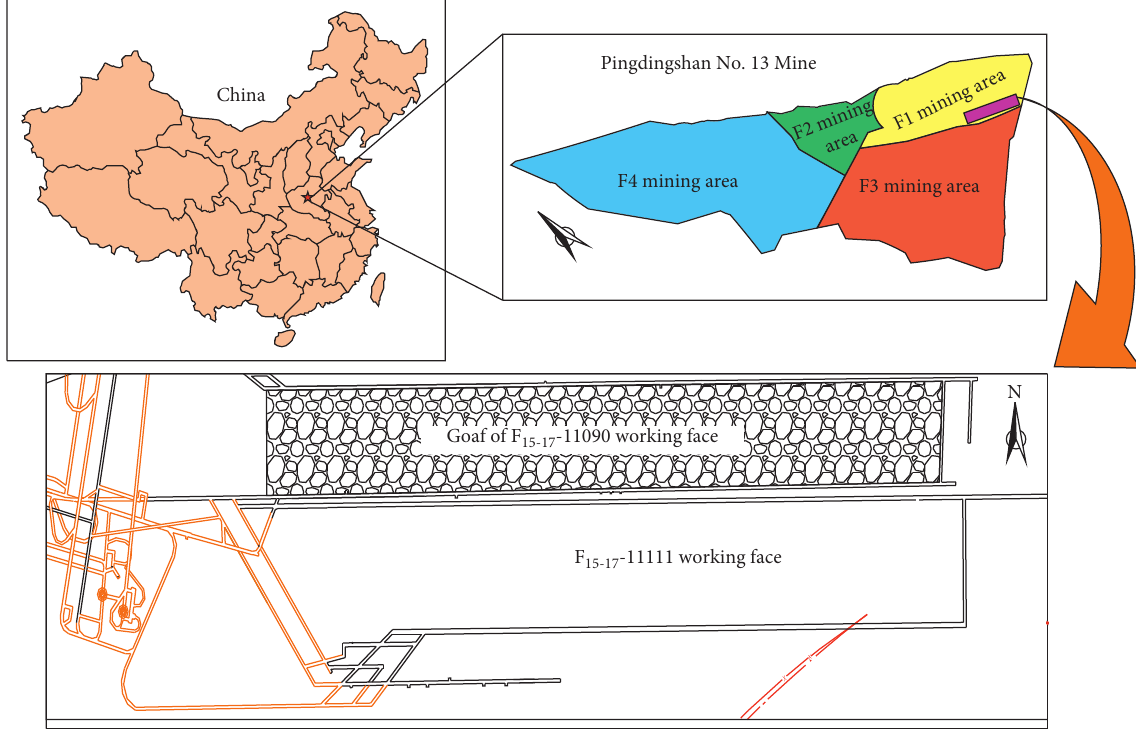
Figure 1: Schematic diagram of the location of the F